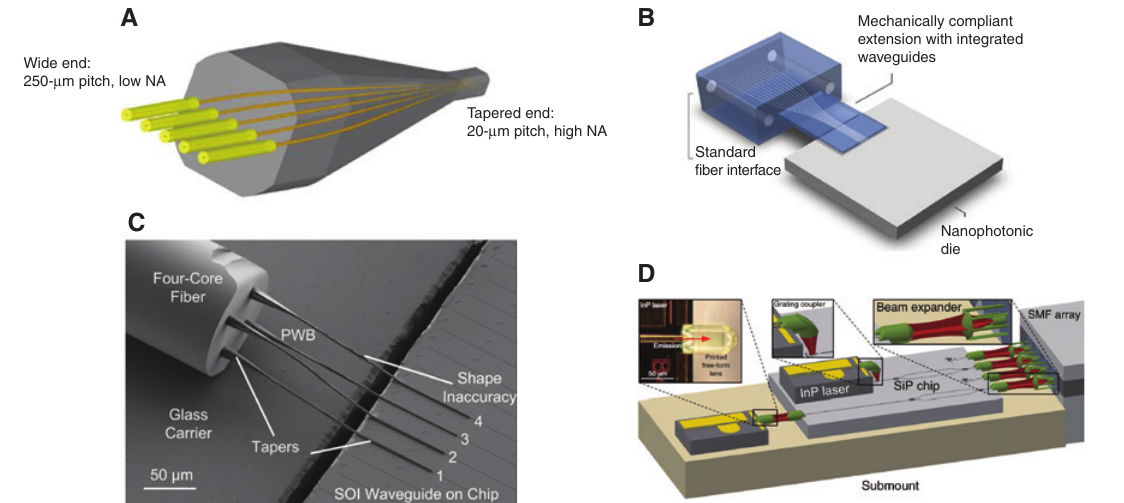
Figure 6: Optical interfaces for multiple ports using intermediate mode transformation stages. (A) Schematic diagram of a multi-channel SSC interconnecting multiple fibers and waveguide arrays. Reprinted from Ref. [70]. Copyright (2011) The Optical Society/IEEE. (B) Schematic diagram of the polymer interface linking an array of standard SMFs to an array of nanophotonic waveguides. Reprinted from Ref. [69]. Copyright (2014) IEEE. (C) SEM image of a multi-core fiber-to-chip interface using photonic wire bonds to connect the individual cores of the multi-core fiber to an array of silicon waveguides. Reprinted from Ref. [71]. Copyright (2015) The Optical Society/IEEE. (D) Schematic diagram of free-form lenses and expanders. Reprinted from Ref. [74]. Copyright (2018) Nature Publishing